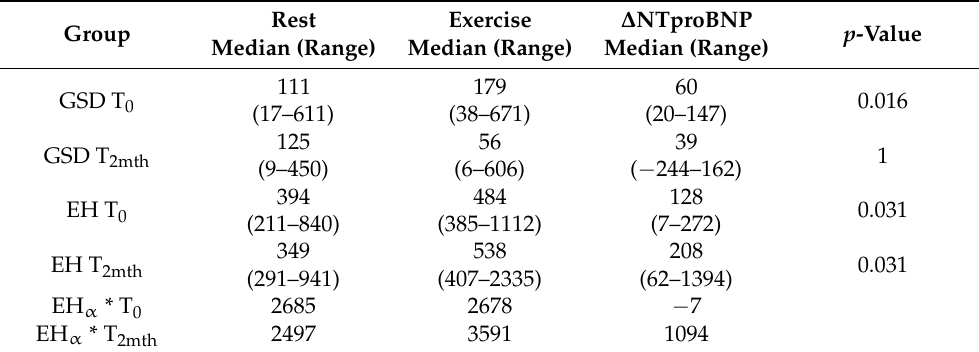
Figure 2. Effects of exercise on NTproBNP in GSDs and EHs at T 0 ( a ) and T 2 ( b ). EHs: Eurohounds; GSDs: German shepherd dogs; ∆ : values of EH α , outlier EH. Table 2. Effect of intensive exercise on NTproBNP serum concentration (pmol/L) in GSDs and EHs, before (T 0 ) and after a training period (T 2mth ).